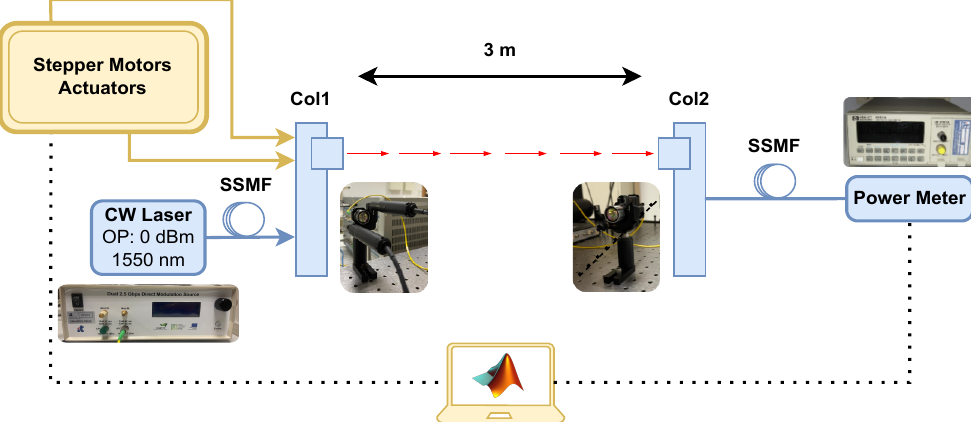
Figure 2. Schematic of the experimental setup used for pointing errors characterization. Color codes: blue—optical components; yellow—control and measuring